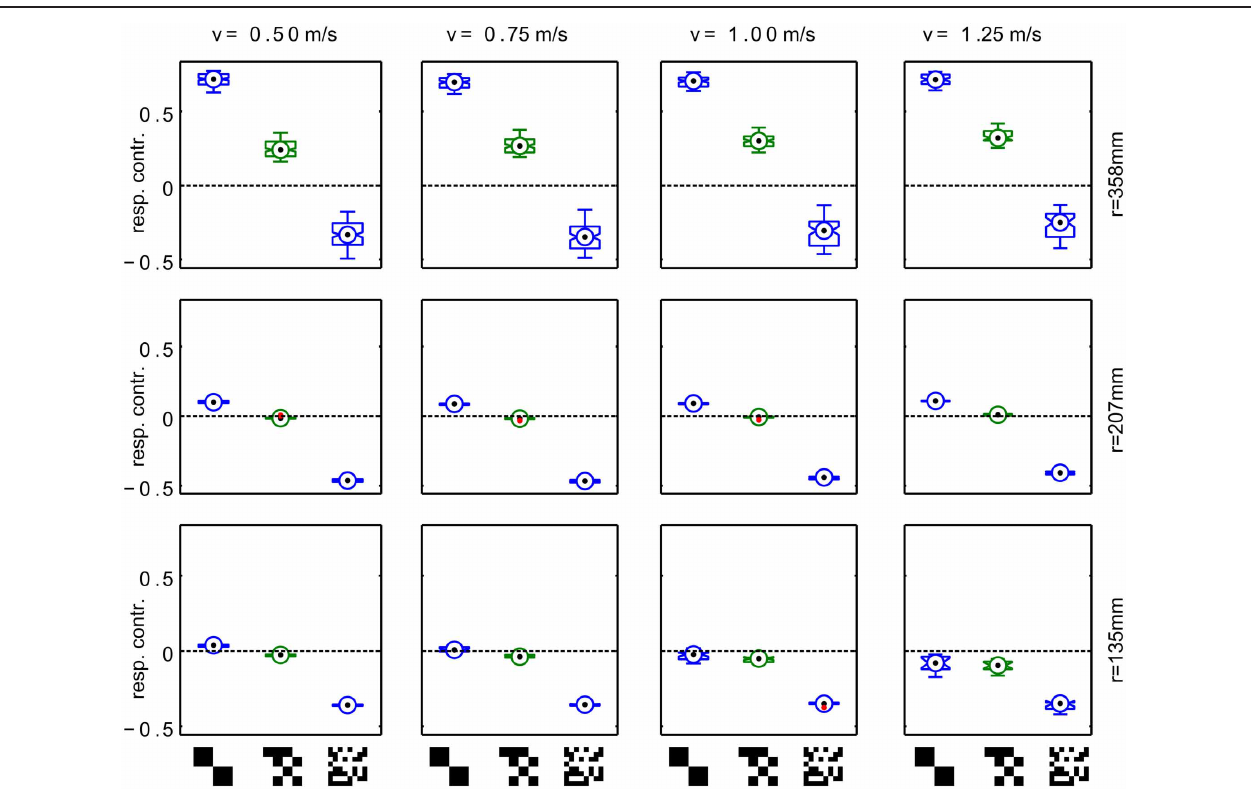
the trajectories varies across rows, the forward velocity in the trajectory varies across columns. The boxplots show median (black dot), quartiles (box), and the range of the data (whiskers). Non-overlapping notches indicate significant difference between two medians at a 5% significance level.